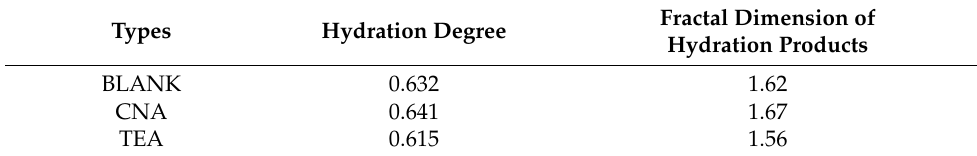
Figure 9. Compressive strength ( a ) and flexural strength ( b ) of cement mortars with different types of early strength agents. Table 5. The hydration degree of the hardened cement slurry at 28 days.